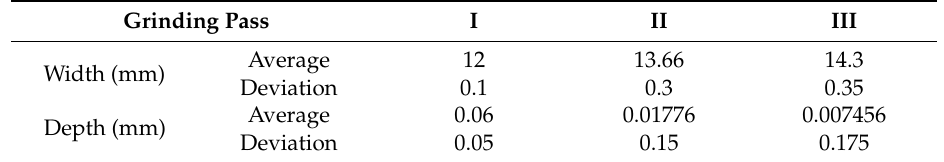
Table 2. Width of the grinding band and grinding depth.